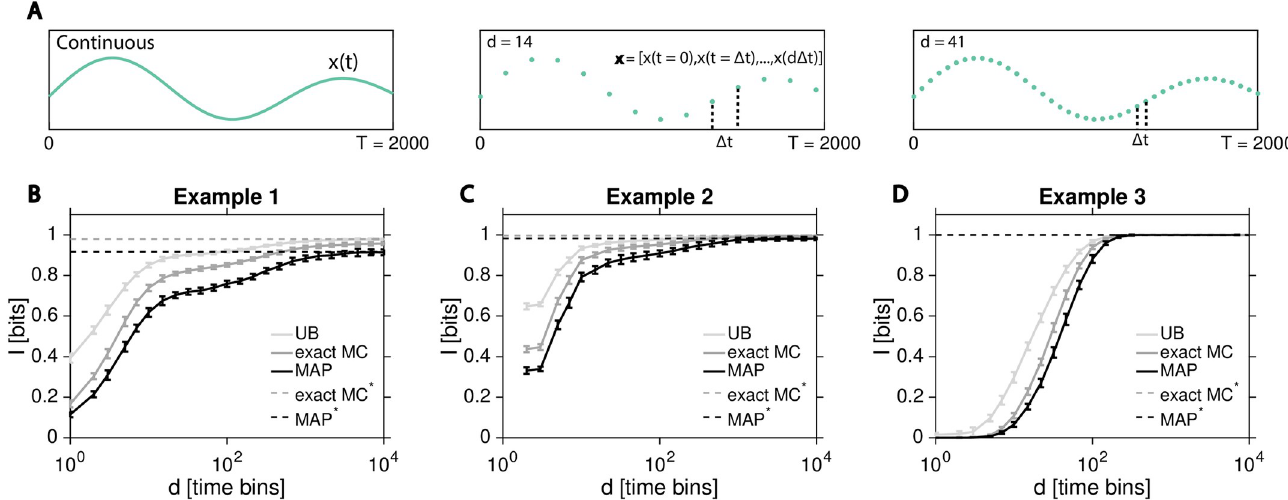
Fig 4. Information loss due to temporal sampling. (A) Schematic representation of the resampling of a continuous-time response trajectory (left) at d = 14 (middle) or d = 41 (right) equally spaced time points. Resampled response trajectories are represented as d -dimensional real vectors, X 2 R d , for the case of a single output chemical species. (B–D) Exact Monte Carlo information approximations for discrete trajectories, I exact ( X ; U ) (dark solid gray), optimal decoding lower bound, I ð ^ U ; U Þ (dark solid black), and the upper bound, I UB (light solid gray) are plotted as a function of d . Continuous-time limits from Fig 3 are shown as MAP horizontal lines: I � ð X ; U Þ (dashed dark gray), I � ð ^ U ; U Þ (dashed black). Error bars as in Fig 3. exact MAP